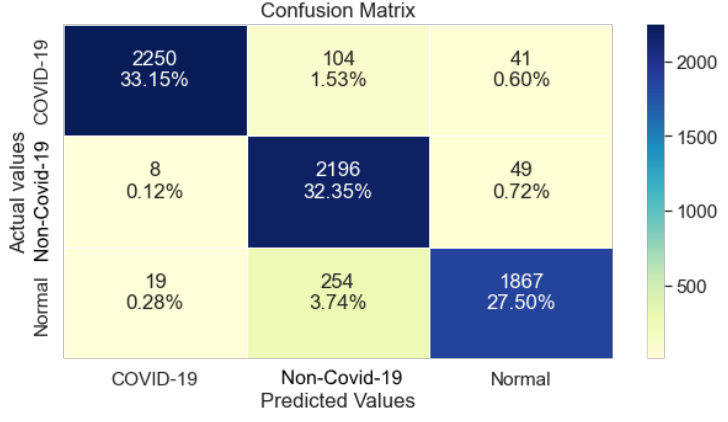
Figure 5. DenseNet121 Confusion Matrix.